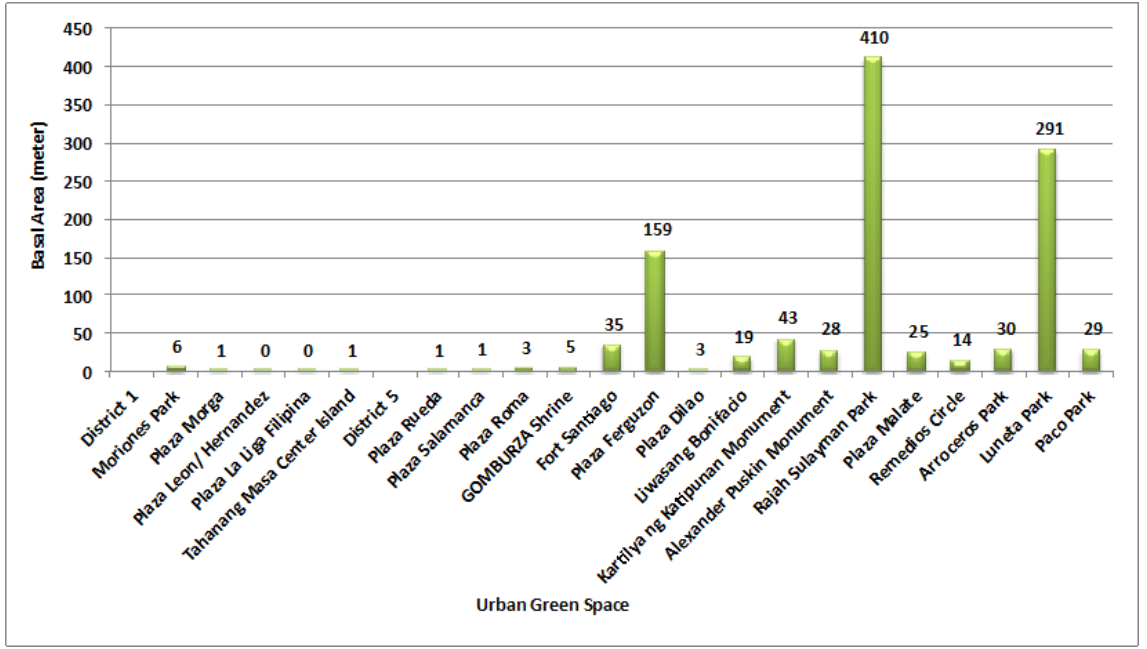
Figure 11. Basalarea of inventoried trees, Districts 1 and 5, Manila City, Philippineson